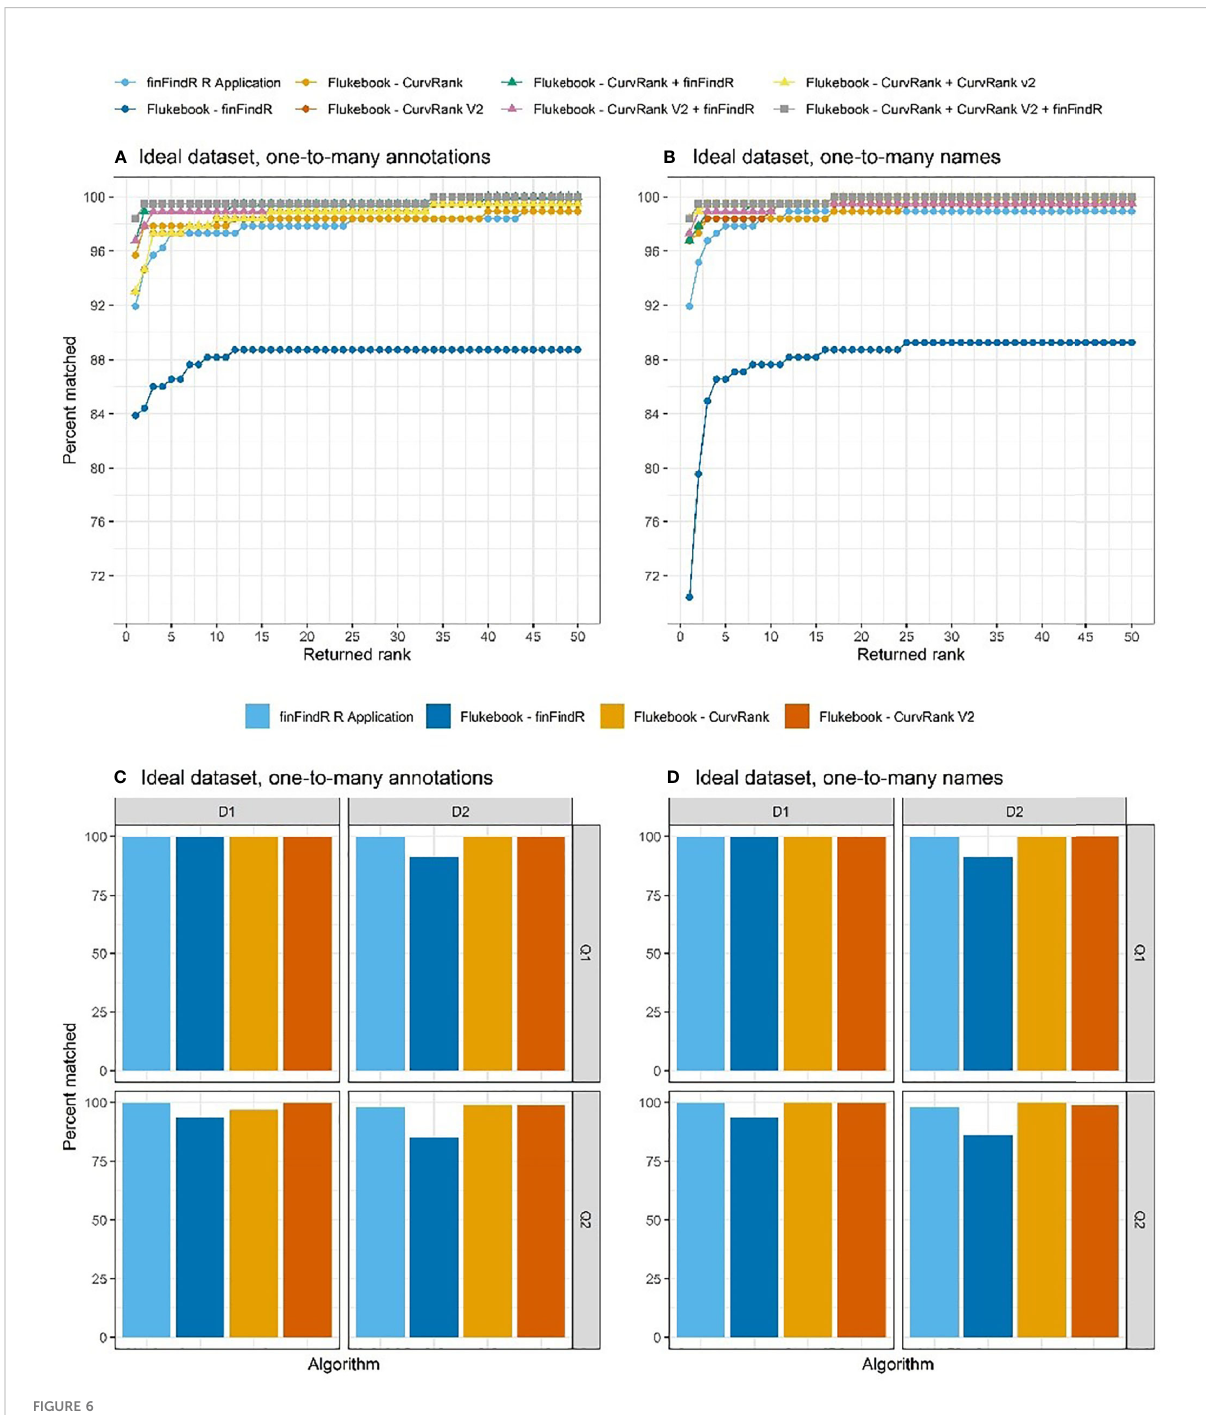
FIGURE 6 The percentage of images correctly matched by each algorithm and combination of algorithms (Flukebook algorithms only) and their cumulative rank position for the ideal tests in the (A) one-to-many annotations comparisons and (B) the one-to-many names comparisons; as well as the percentage of images of varying image quality and fi n distinctiveness correctly matched by the independent algorithms for the ideal tests in the (C) one-to-many annotations comparisons and (D) the one-to-many names comparisons. For reference, Q1 = excellent quality image, Q2 = average quality image, D1 = very distinctive fi n, and D2 = average amount of distinctive features on fi n (Urian et al., 1999; Urian et al.